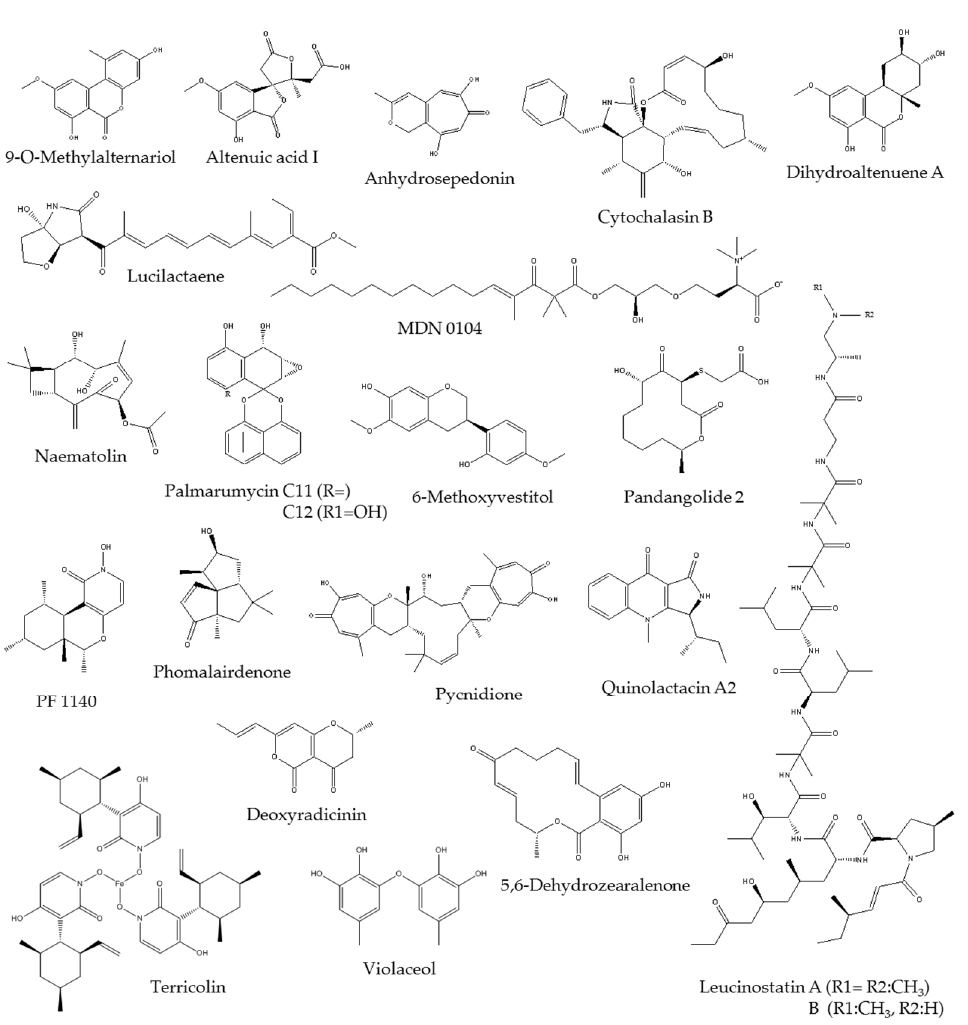
Figure 5. Chemical structures of dereplicated known metabolites induced by the addition of SAHA to fermentations of leaf litter fungal strain population.